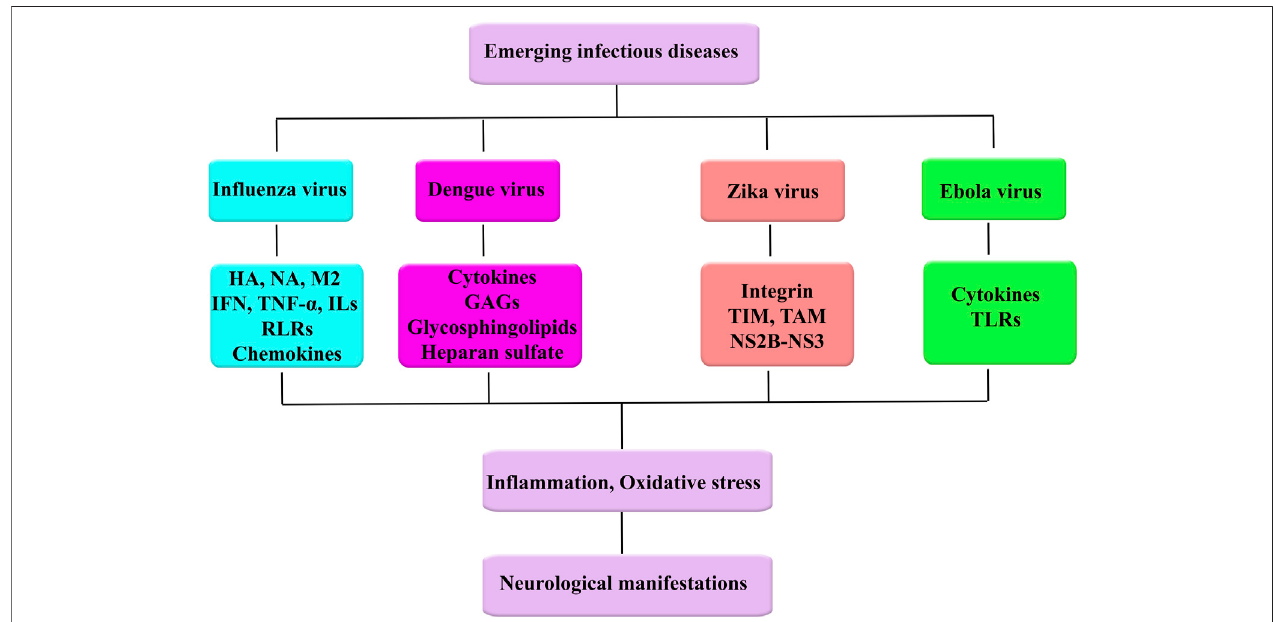
FIGURE 1 | Emerging infectious diseases and associated dysregulated mediators towards neurological